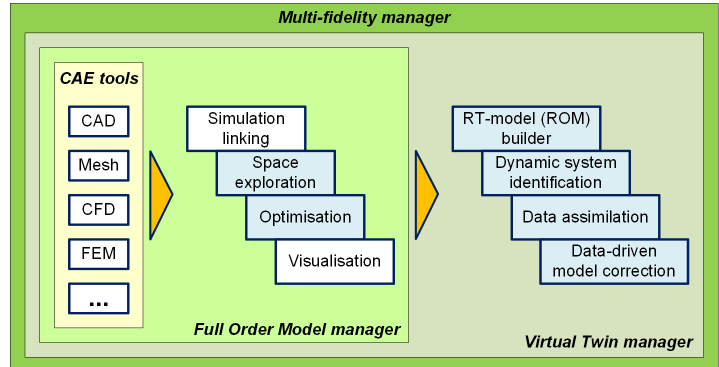
Figure 7. DDDAS workflows to create the sub-systems multi-fidelity models.